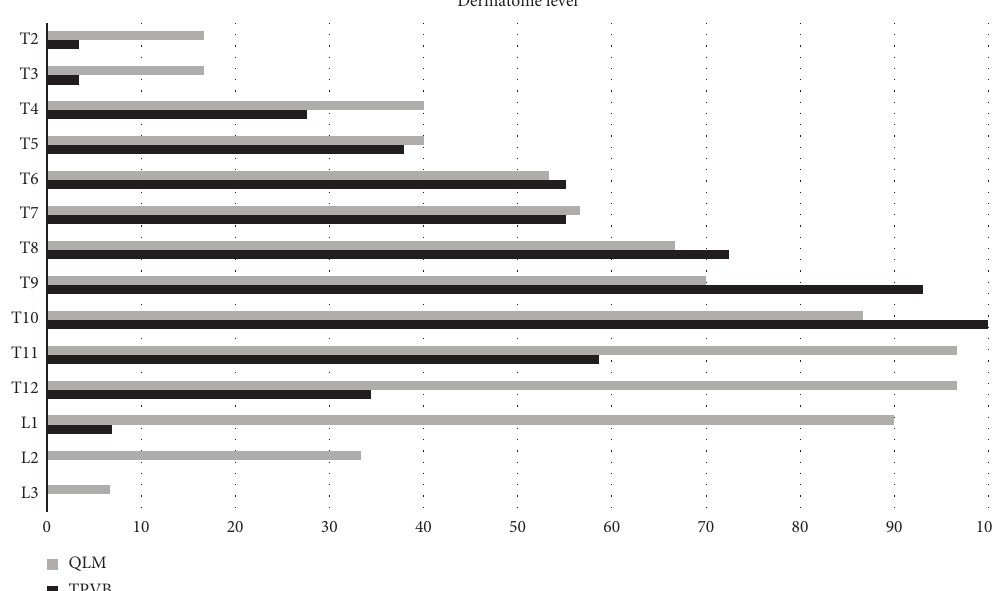
Figure 3: Range of dermatomal sensory block